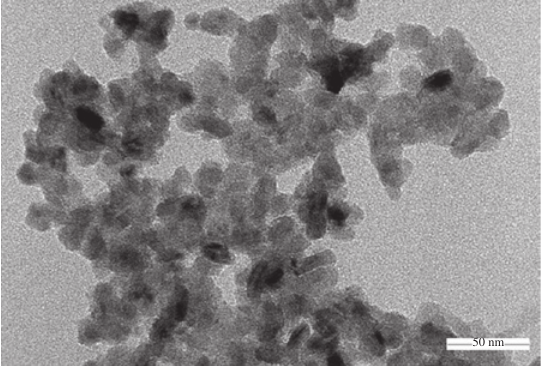
nanoparticles. 2